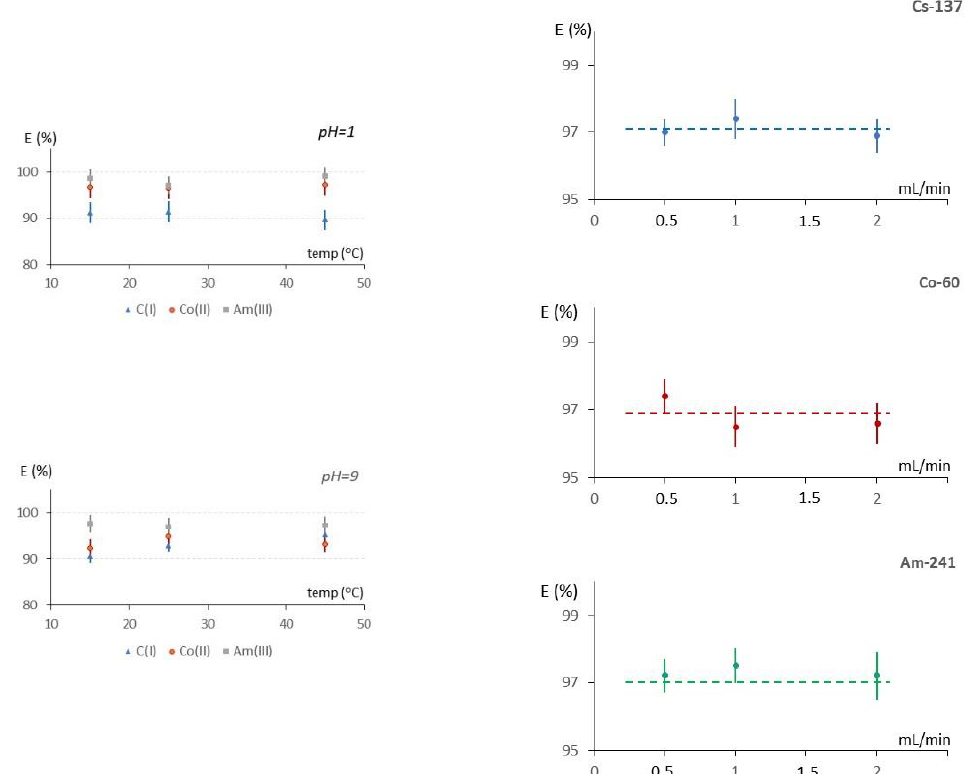
Figure 5. Temperature dependence of removal of Cs(I), Co(II) and Am(III) radionuclides from wastewater ( left ) and the purification efficiency, E (%), as a function of flow rate of the solution ( right ).